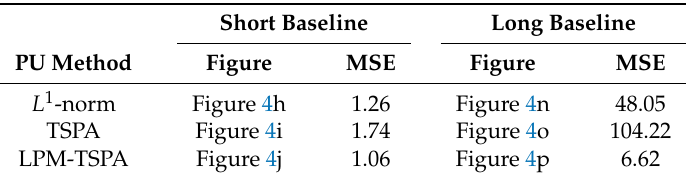
Table 3. Statistical Information of PU Performance in Figure 4h–j and n–p.